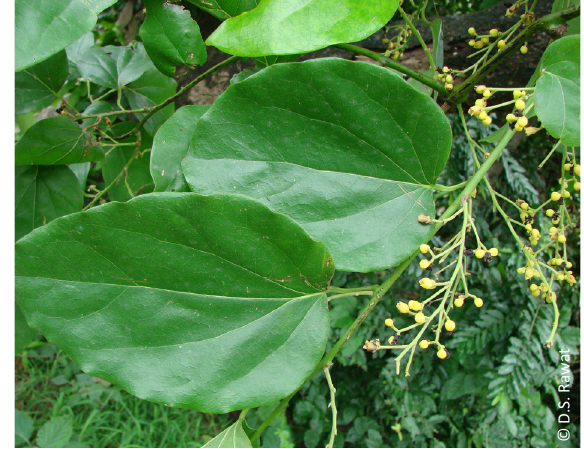
Image 1. Tiliacora acuminata (Lam.) Miers